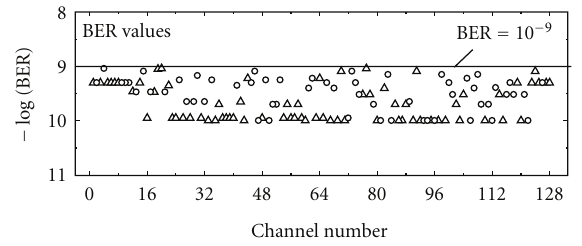
Figure 7: BER values for all 128 tributaries. All channels are error- free (BER < 10 − 9 ) corroborating the open eyes from Figure 1, taken from